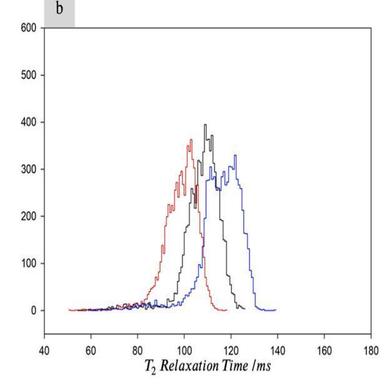
Histograms showing the distribution of MR T2 relaxation time across all pixels for three samples after 1 (a) and 3 (b) freeze thaw cycle, and after a further 3 days of equilibration (c).